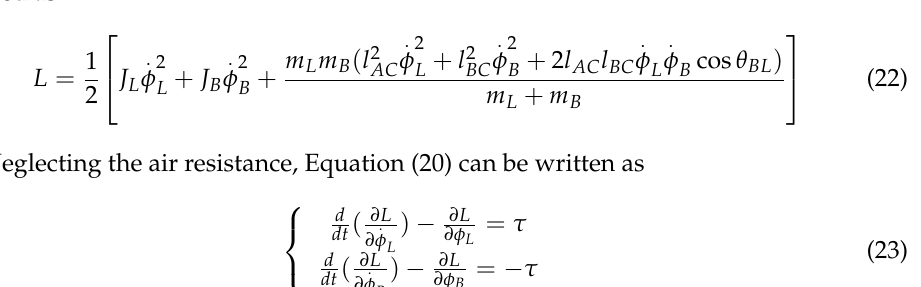
Figure 18. Simulation results for gliding trajectory.